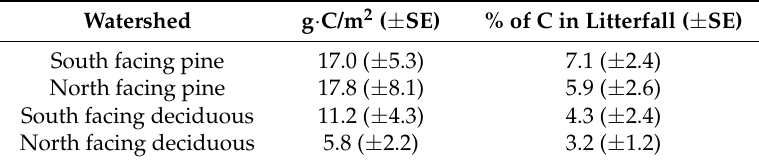
Table 5. Accumulation of forest floor C older than 13 years.